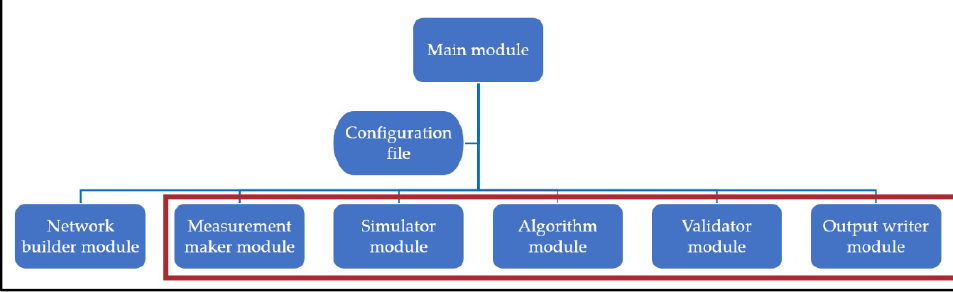
Figure 2 . Architecture of the DSSE tool . Modules inside the red box perform the run of DSSE, Figure 2. Architecture of the DSSE tool. Modules inside the red box perform the run of DSSE, while while those outside the red box perform data management and preprocessing. those outside the red box perform data management and